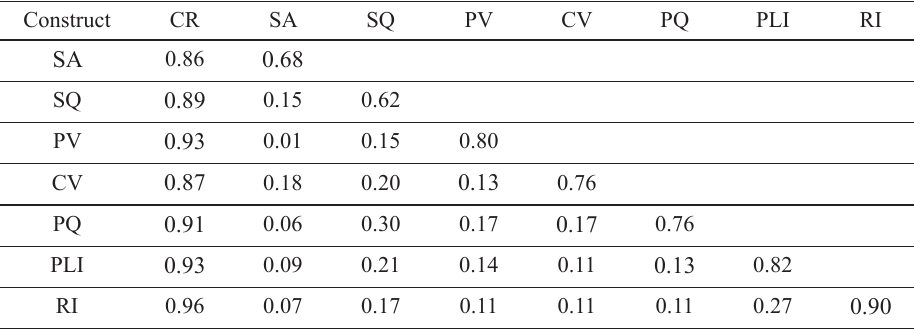
Table 2. Reliability, convergent validity, and discriminant